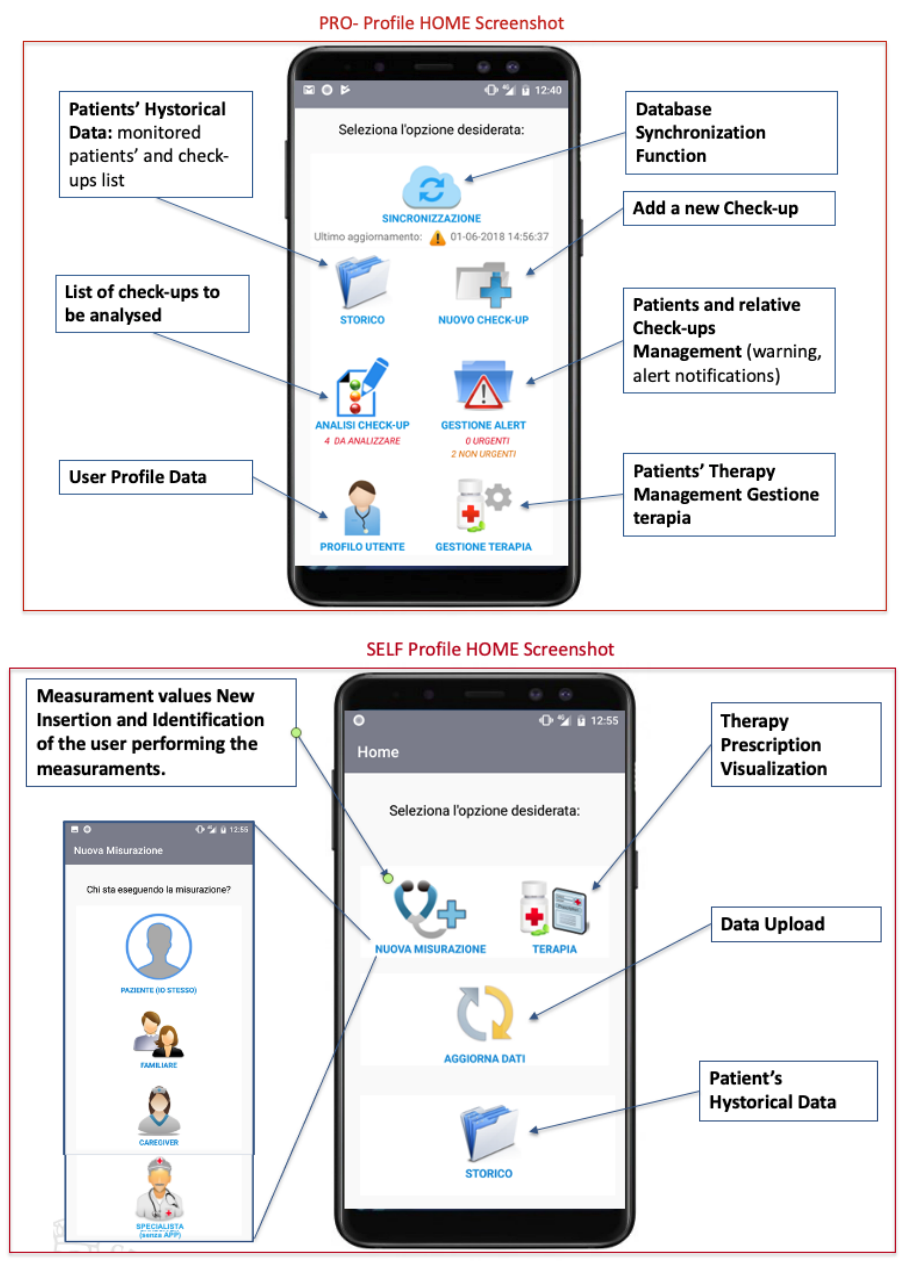
Figure 4. Overview of the System Monitoring Components and Data Sharing.